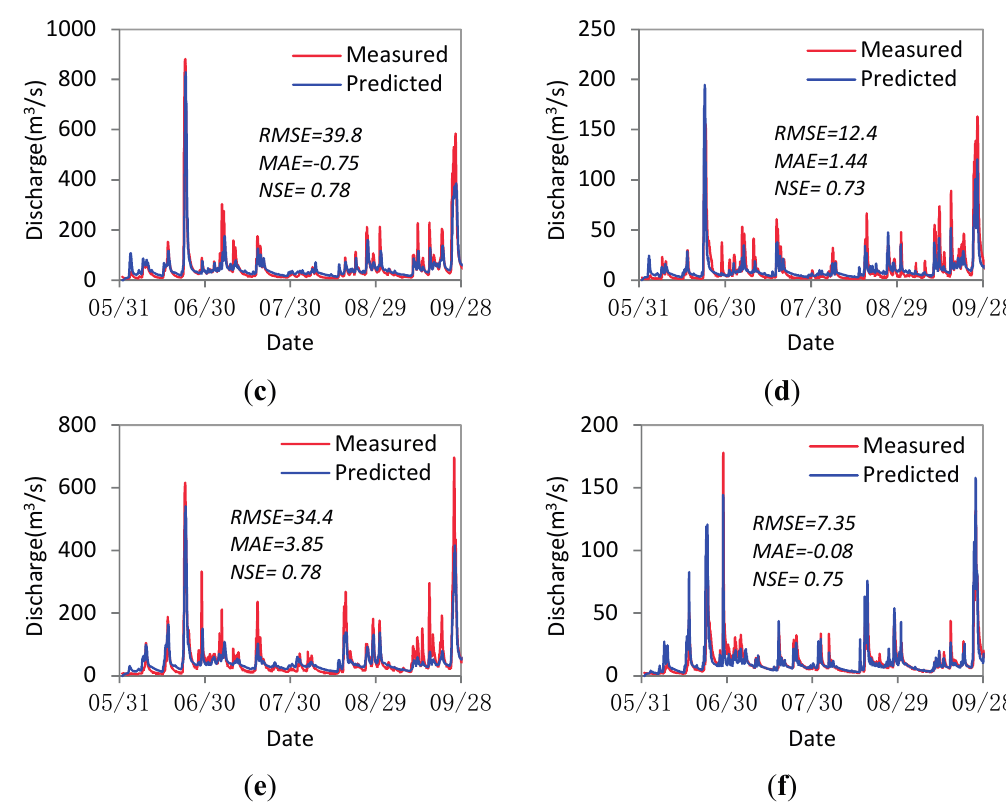
Figure 2. Hydrological verification of discharge from June to September 2012 for controlled sites (see Figure 1 for locations) at sites: ( a ) Site 711610 (see Figure 1); ( b ) Site 713122; ( c ) Site 713019; ( d ) Site 720517; ( e ) Site 724629; ( f ) Site